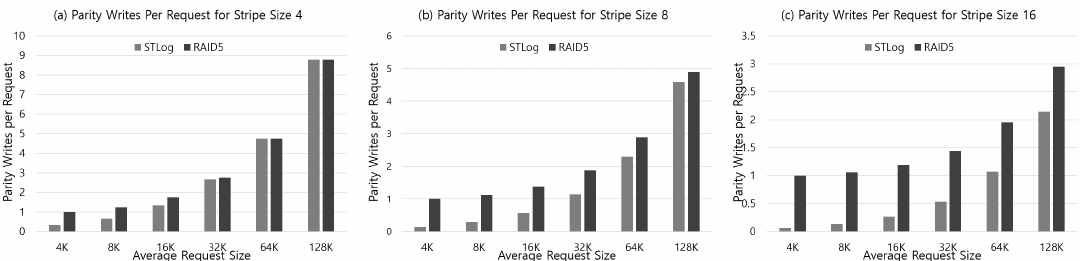
Figure 13. Result of the number of parity writes per request according to the change in the average request size, for each stripe size four, eight, 16,